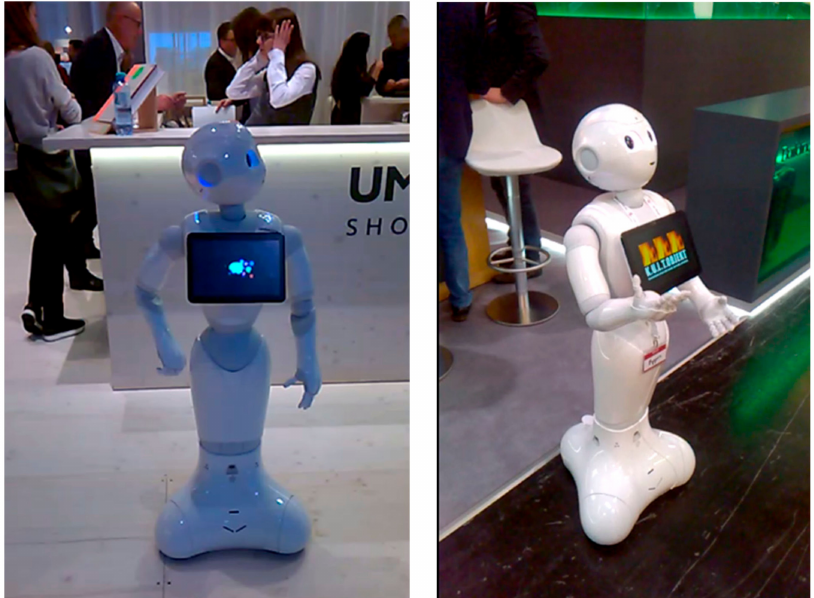
Figure 1. Pepper robots acting as hosts in large enterprise stands at the EuroCIS 2017 trade fair for retail technologies in Dusseldorf,